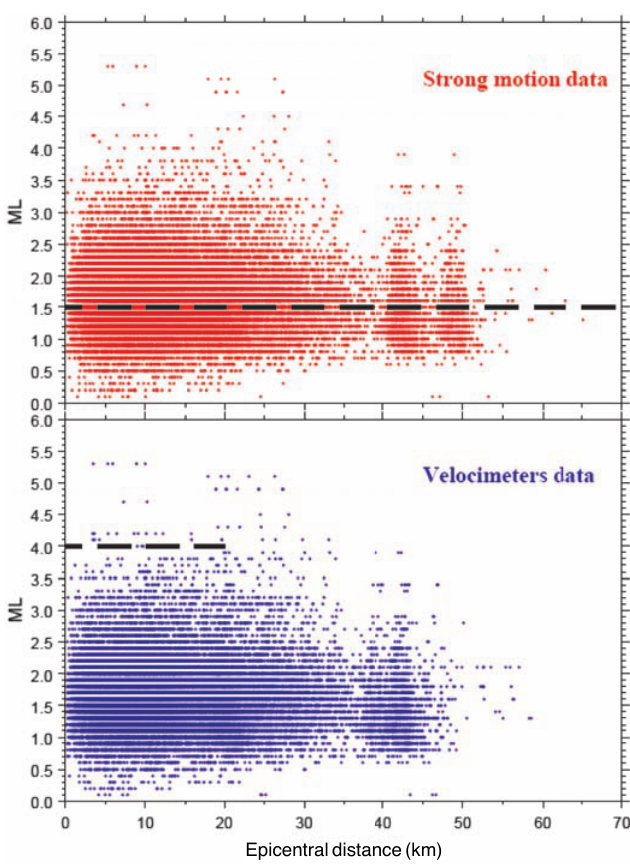
Figure 4. Magnitude versus epicentral distance distribution of the events recorded. Top panel: records from the strong-motion sensors. Bottom panel: records from the weak-motion sensors. In both panels, the data located above and below the dashed lines indicate records with low signal- to-noise ratio (top panel, for the accelerometers) and possible signal saturation (bottom panel, for